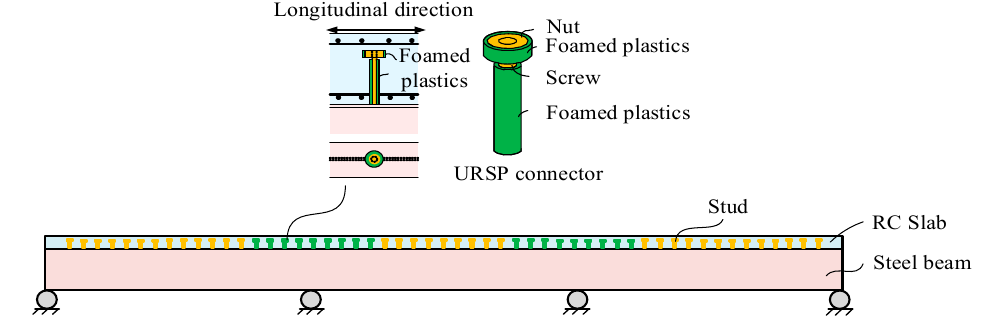
Figure1. Figure 1. Uplift-restricted and slip-permitted (URSP) connectors in a continuous composite beam bridge.